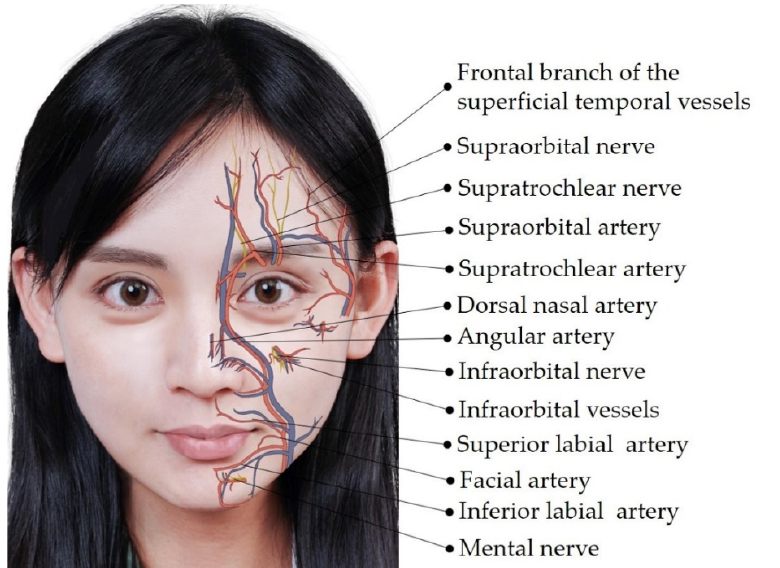
Figure 1. Illustration showing the frontal facial neurovascular structures. Blue structures indicate veins, which are mostly accompanied by arteries (in red) with the same nomenclature.